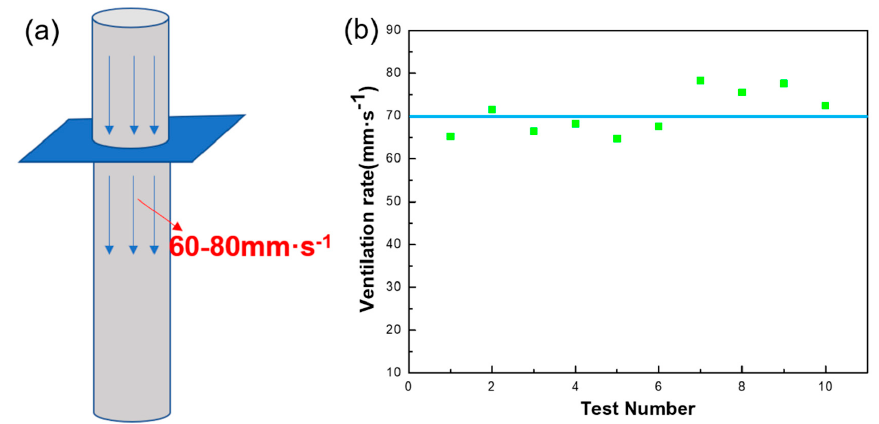
Figure 8. The air permeability of CPFMs. ( a ) Schematic diagram of air permeability tester; ( b ) ventilation rate of the CPFMs, which is between 60 to 80 mm · s − 1 .